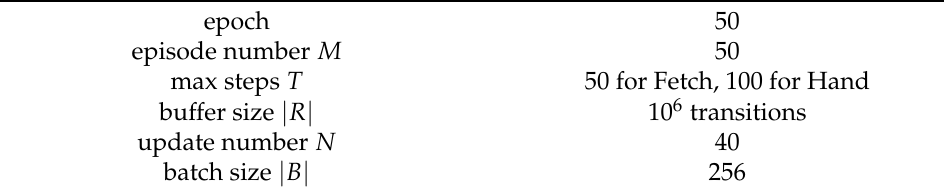
Table 3. Main controlling and training parameters for